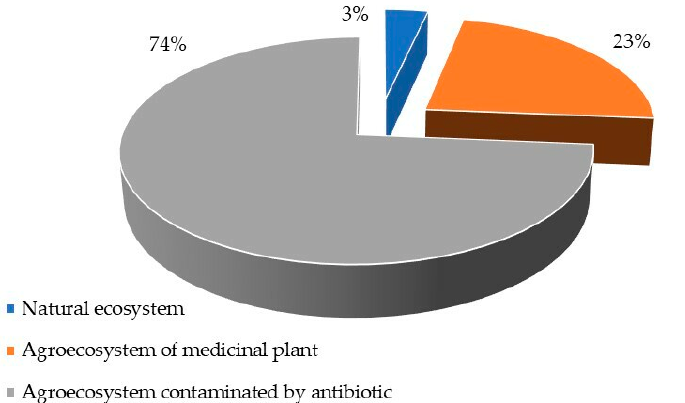
Figure 3. Percentage of bacteria in the different ecosystems with levels of AR for tested antibiotics greater than 30%, p < 0.05.